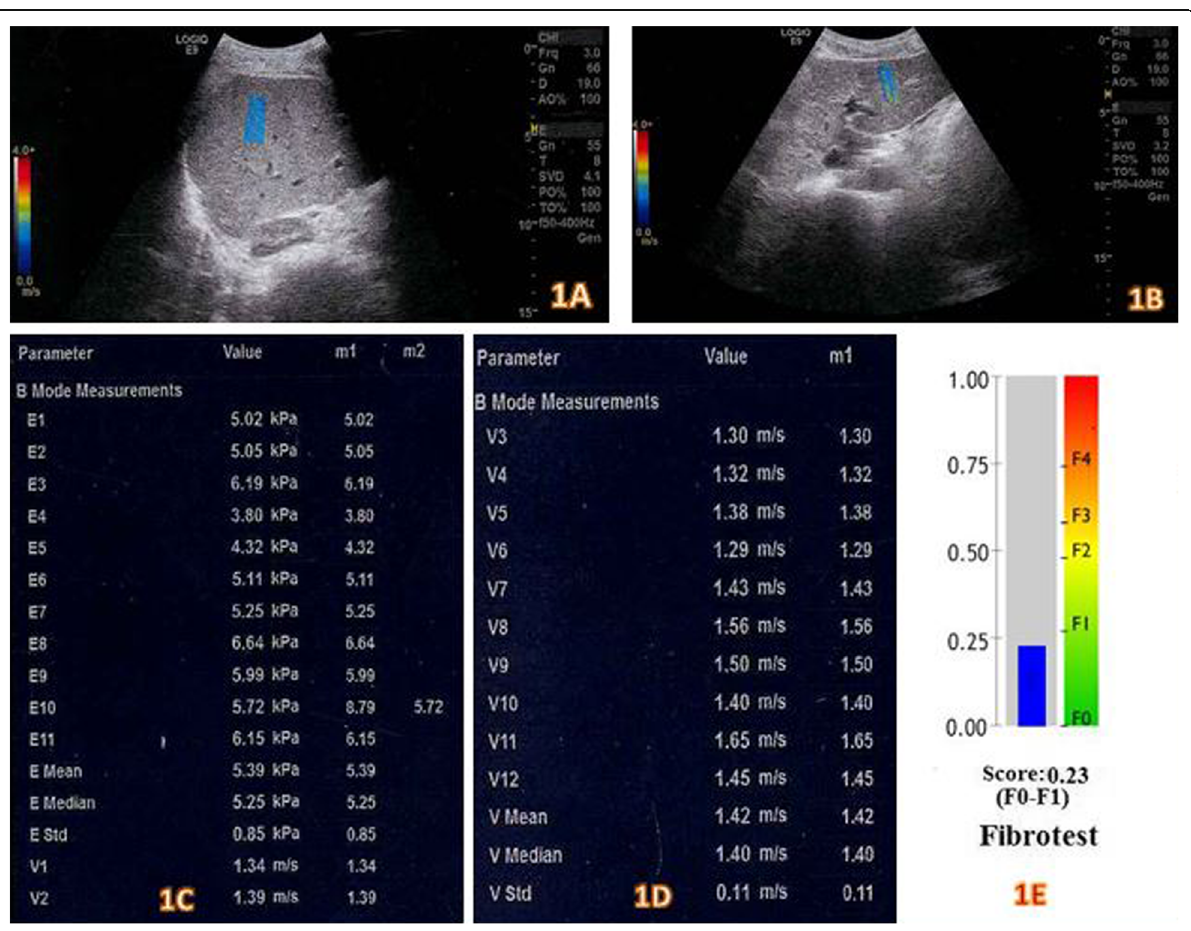
Fig. 1 F0 stage: A male patient aged 48 years old with HCV chronic hepatitis and normal AST and ALT. Conventional US reveals the following ( a and b ): Liver >>smooth surface (score 1), homogeneous echopattern (score 1), smooth hepatic veins (score 1) “ cumulated score 3. ” No ascites, top normal spleen size, normal portal vein caliber, single GB stone. 2D shear wave elastography ( c and d ): Velocity median value = 1.40 m/s. Stiffness median value =5.25 kPa. Fibrotest result was 0.23 denoting F0-F1 stage ( e